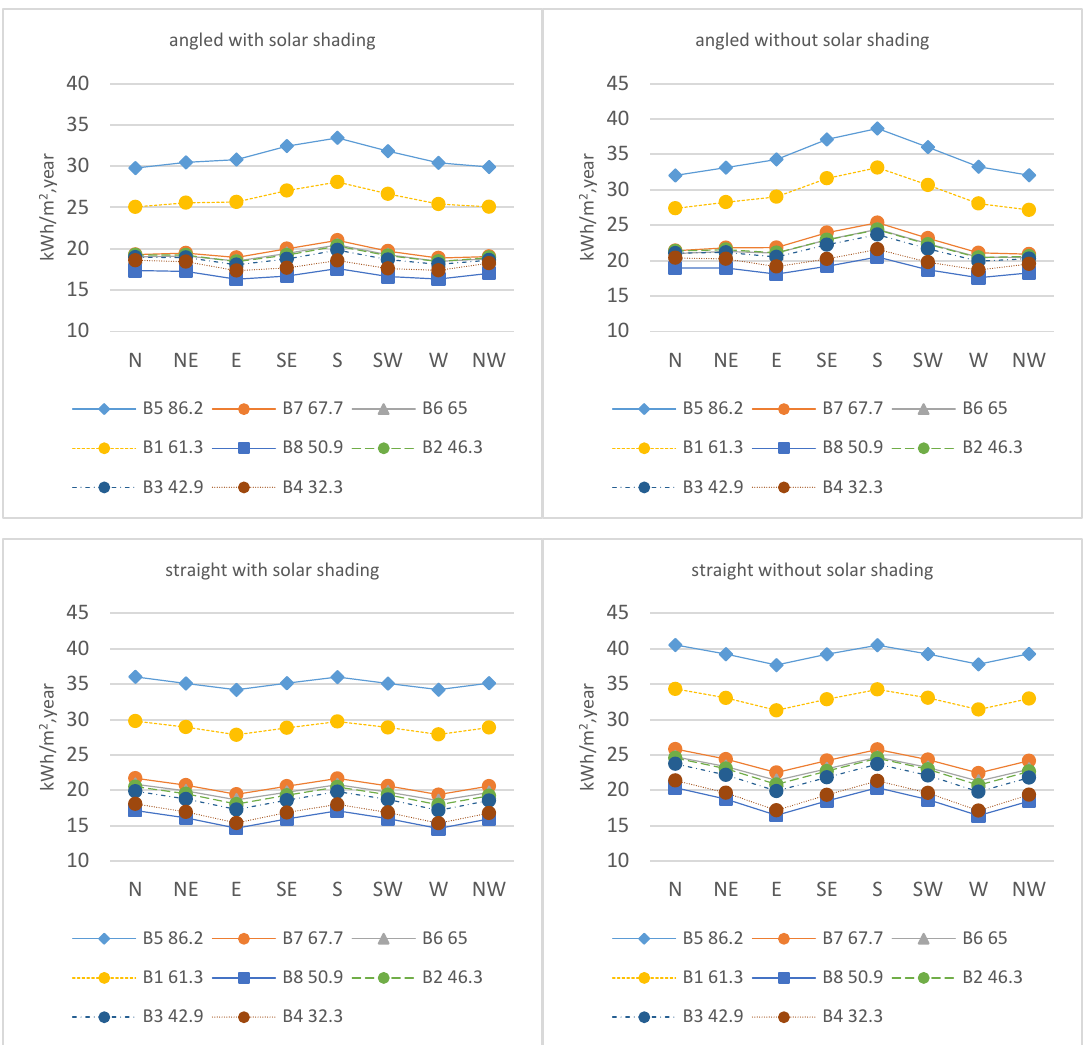
Figure 5. The total energy use for heating and cooling as a function of rotation of the office building in the city of Malmö. The eight different types of markers show results for each different amount of internal gain used in the simulations. The lines between the markers are only for the ease of interpretation. The top left is an angled façade with solar shading, the top right has an angled façade without solar shading, the bottom left has a straight façade with solar shading and the bottom right has a straight façade without solar shading.